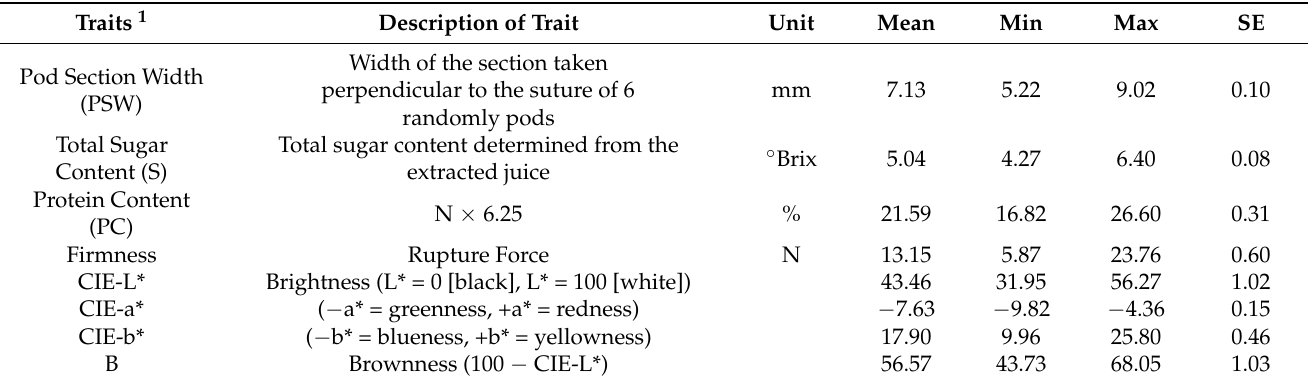
Table 2. Mean, interval of variation (Min, Max), and standard error (SE) for the traits recorded in the set of 54 snap bean lines.